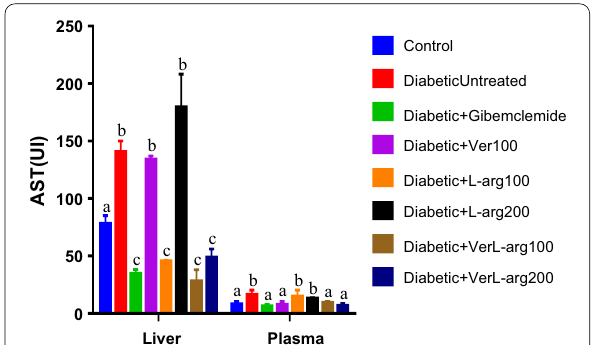
Fig. 13 Aspartate-amino transferase activity in diabetic mice treated with verbenone, L-arginine and ratios of verbenone L-arginine (1:1 + v/m) after 14 days treatment. Values are expressed as mean SEM, ± n 5. Values with different superscripts are significantly different at = p < 0.05. VerL-arg verbenone L-arginine (1:1 v/m) = +